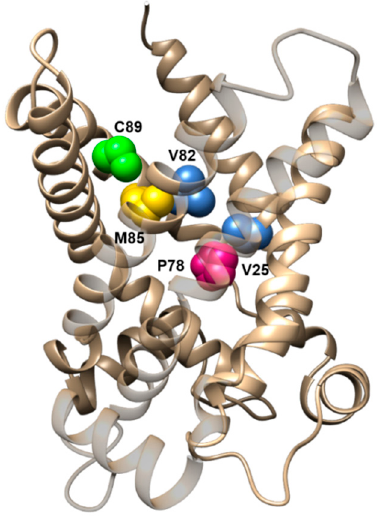
Figure 4. Lateral view of the CAC structural model highlighting the residues involved in binding the acyl moieties of acyl-carnitines. CAC residues are displayed with sphere representation. Once the carnitine or the acyl-carnitine has interacted with the proper residues in the c-state, a charged gate constituted by the amino acid side chains of Asp-32, Lys-35, Glu- 132, Lys-135, Asp-231, and Lys-234 (Figure 5a) located below the binding site, needs to be unlocked for the translocation to occur [99,104–107]. The six residues form three ion pairs resulting from the interactions between the couples: Asp-32 with Lys-135, Glu-132 with Lys-234, and Asp-231 with Lys-35. The role of these residues and their interactions have been validated using the mutagenesis approach [87]. Once the gate is opened by the fast interaction of the substrate with at least one of the charged residues, i.e., Lys-35, the carrier changes its conformation from the cytosolic state opened to the matrix opened state. The protein is stabilized in the matrix opened conformation by a gate, similar to the matrix one that is formed towards the cytosolic face and is composed of four charged residues, namely, Lys-97, Glu-191, Lys-194, and Glu-288 (Figure 5b). The other two residues of the cytosolic gate of CAC are uncharged in contrast to the corresponding residues of other carriers [96,106]. The free energy of the cytosolic gate of CAC is, therefore, lower than that of the matrix gate. This probably determines an imperfect coupling of the flux of sub- strates in the outward and inward directions, conferring to CAC the capacity to mediate a uniport reaction besides the antiport reaction [31,106]. Figure 5. Lateral views of CAC highlighting the residues of the matrix and cytosolic gates. ( a ) The residues Asp-32, Lys-35, Glu-132, Lys-135, Asp-231, and Lys-234 forming the matrix gate are depicted in red (negatively charged residues) or in blue (positively charged residues); ( b ) the residues Lys-97, Glu-191, Lys-194, and Glu-288 forming the cytosolic gate are depicted in red (negatively charged residues) or in blue (positively charged